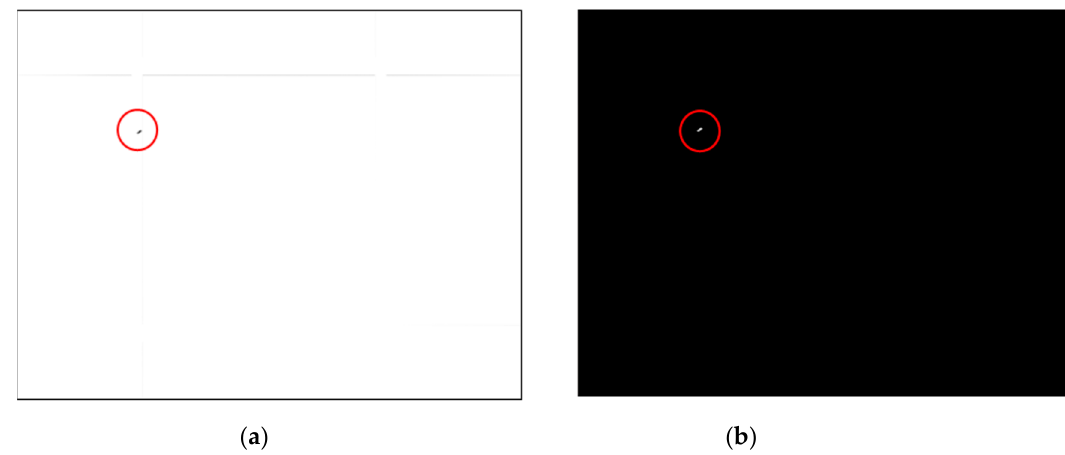
Figure 17. ( a ) Image with defects and noises; ( b ) Applying closing operation, binarization, and image complement to ( a ) to remove the noises and identify defects in the interval.